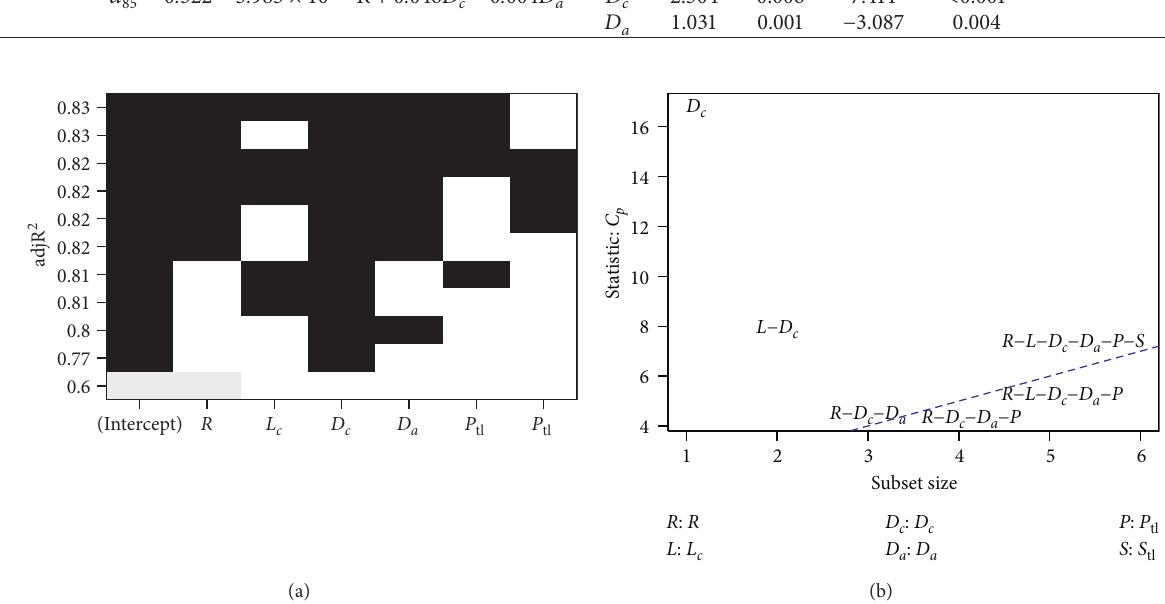
Figure 5: Model selection based on (a) adjusted R -square and (b) C